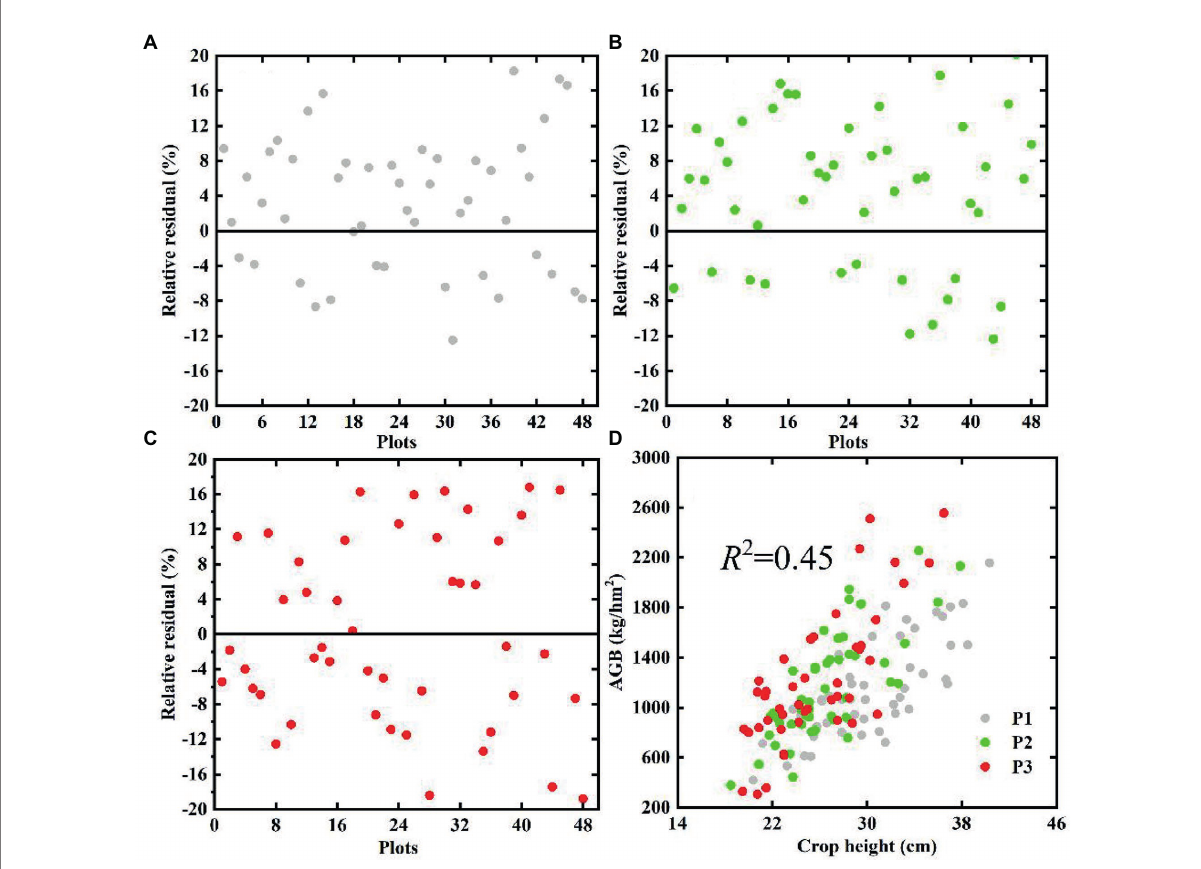
FIGURE 5 Comparison of the relative residuals (%) of the extracted crop height during the growth period of potato (A) P1, (B) P2, (C) P3, and (D) the relationship between AGB and estimated crop height based on